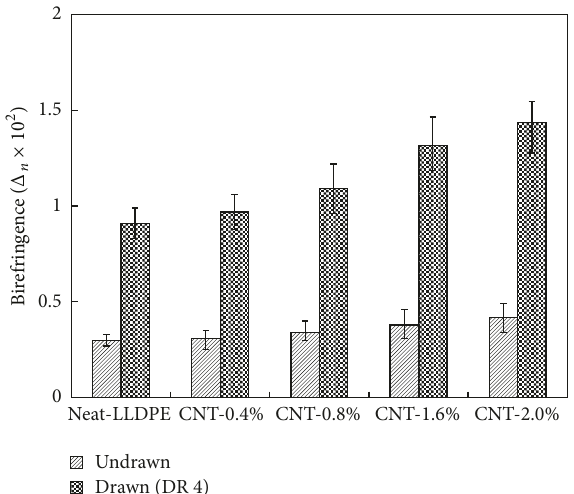
Figure 3: Birefringence (Δ 𝑛 ) of undrawn and drawn LLDPE fibers as a function of CNTs content.